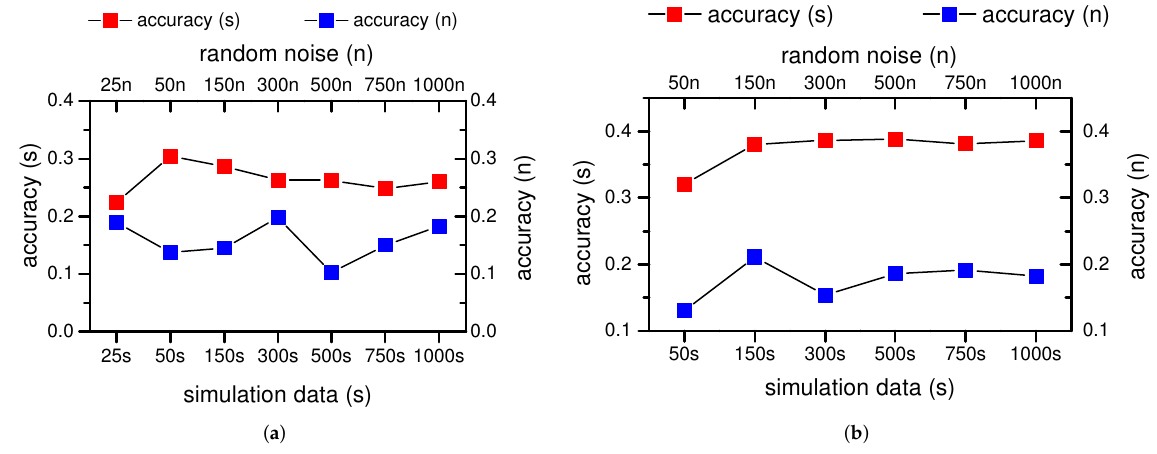
Figure 10. Fault classification under case B. ( a ) 0.021 inches, ( b ) 0.014